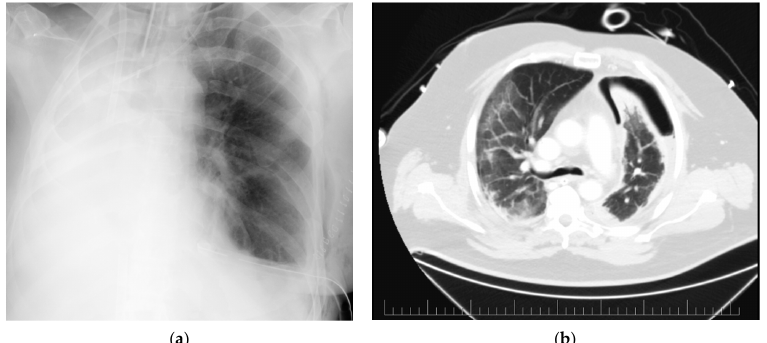
Figure 1. Radiographic images of presented cases: ( a ) Postoperative chest X-ray of a patient after left-sided double atypical resection and previous right-sided pneumonectomy (ECMO cannulas introduced via right internal jugular and femoral veins); ( b ) Preoperative CT scan of a patient with bilateral COVID-19 pneumonia with a ground glass and crazy paving pattern and left-sided pneumothorax.